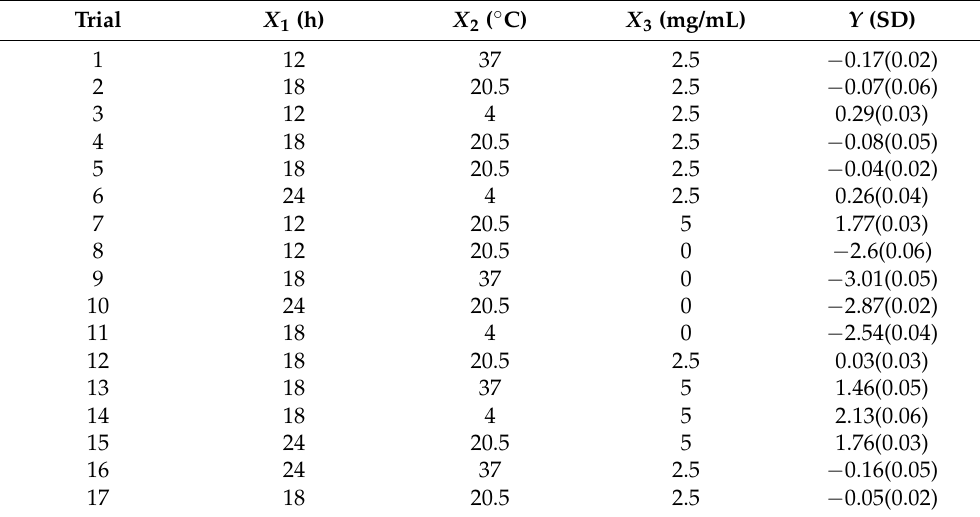
Table 1. The design and response of the Box–Behnken experiment of CA against the growth of Y. enterocolitica .